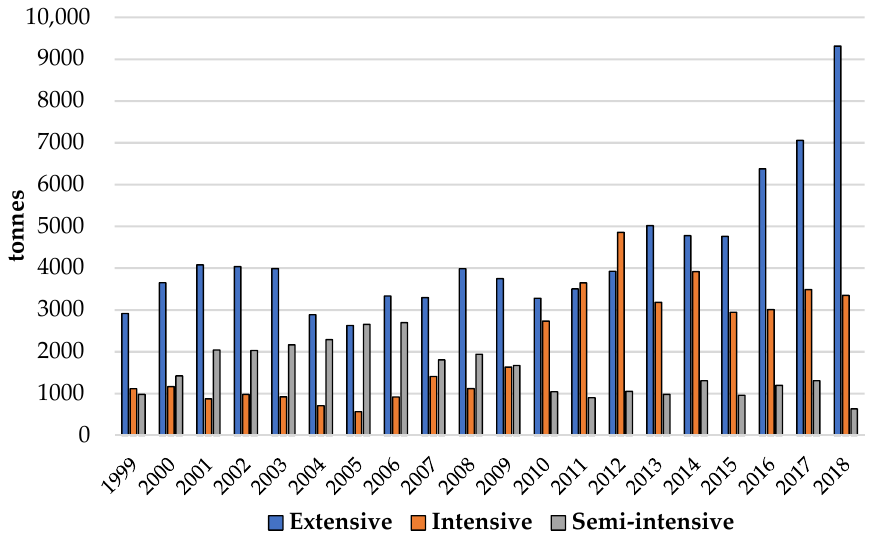
Figure 4. Aquaculture production of each of the three rearing systems in the period between 1999 and 2018. Data sources: INE 2000; INE 2002-2019.